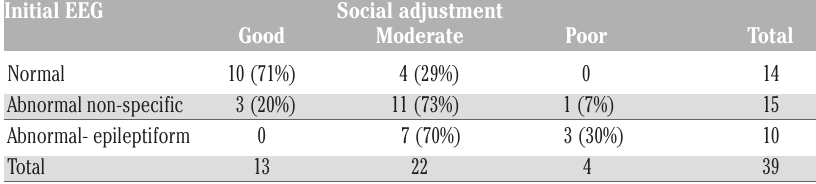
Table 4. Social adjustment of patients in relation to the initial